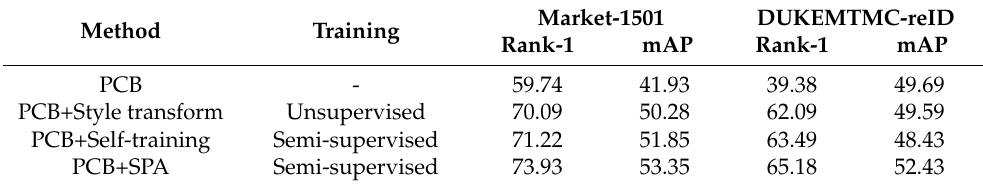
Table 5. Ablation study on different components of the proposed